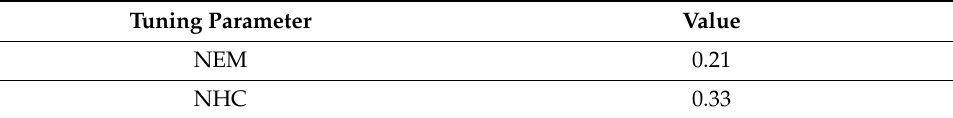
Table 5, depending on the engine coolant temperature Table 5. Optimized values of the NO x model calibration parameters. Tuning Parameter